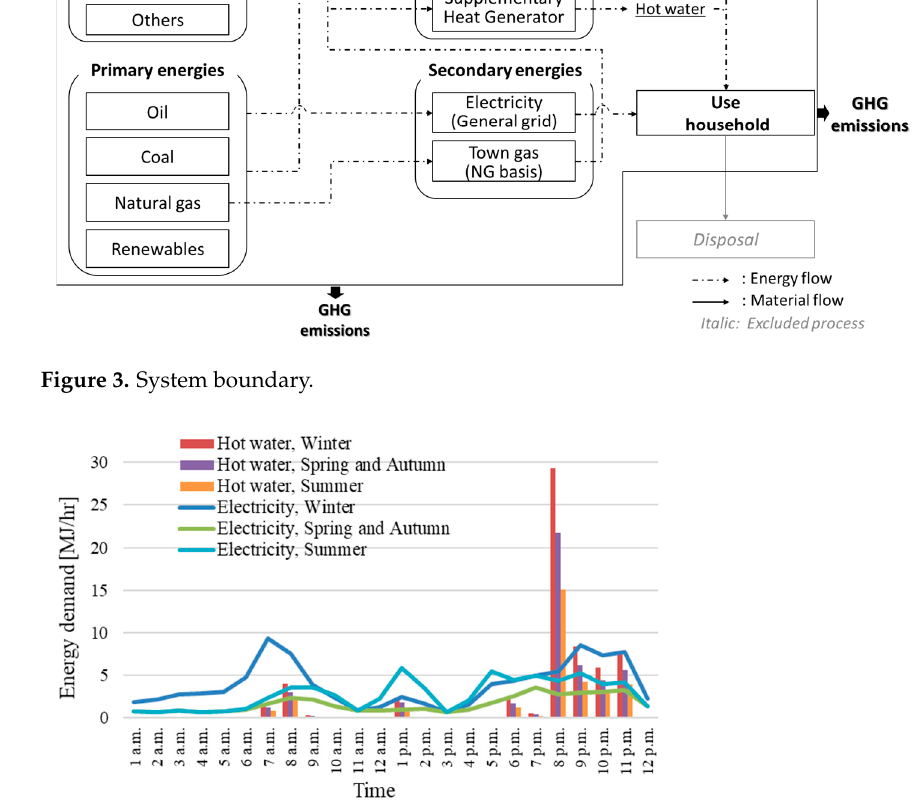
Figure 4. Energy demand considering seasonal variation [40].